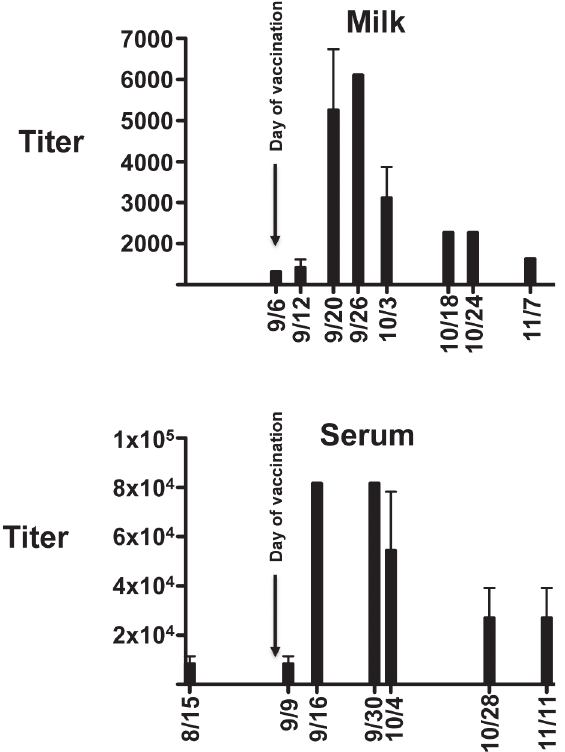
Fig 5. Anti-tetanus toxoid IgG titers in milk and serum following booster vaccination with tetanus toxoid. The graphs show anti-tetanus IgG antibody titers (y-axis) for milk and serum from an adult female Asian elephant. Samples were tested on days indicated below the x-axis. The results are shown as the mean plus standard deviations from three independent experiments.